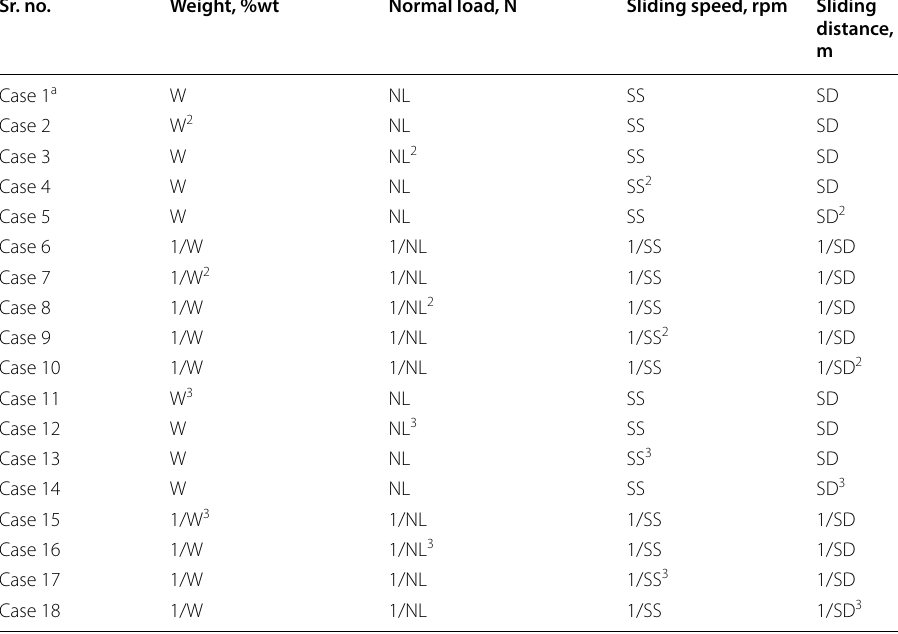
Key: a Case 1 and its data are taken from Kumar and Reddy [13]